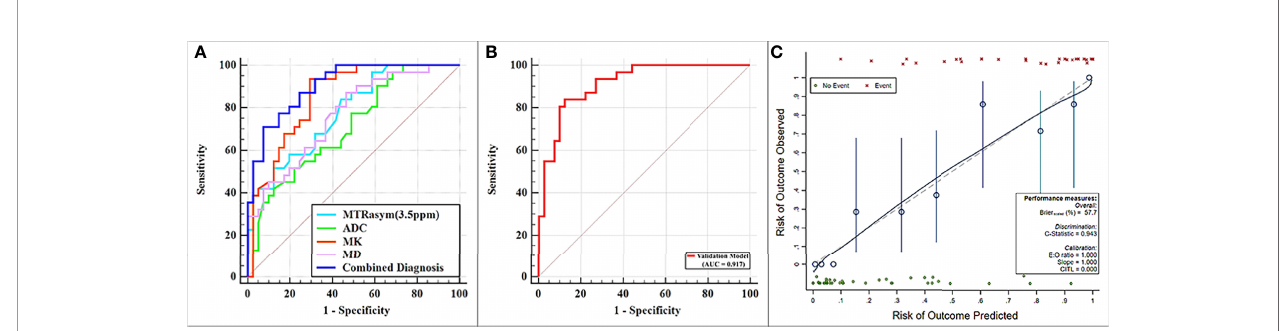
FIGURE 5 | (A) Receiver operating characteristic (ROC) curves showing each parameter and the combination of mean diffusivity (MD), mean kurtosis (MK), and magnetization transfer ratio asymmetry (MTRasym, at 3.5 ppm) for the differentiation of low- and non-low-risk stage I endometrial cancer (EC) patients. (B, C) ROC and calibration curves for predicting risk strati fi cation of stage I EC patients in the validation model.